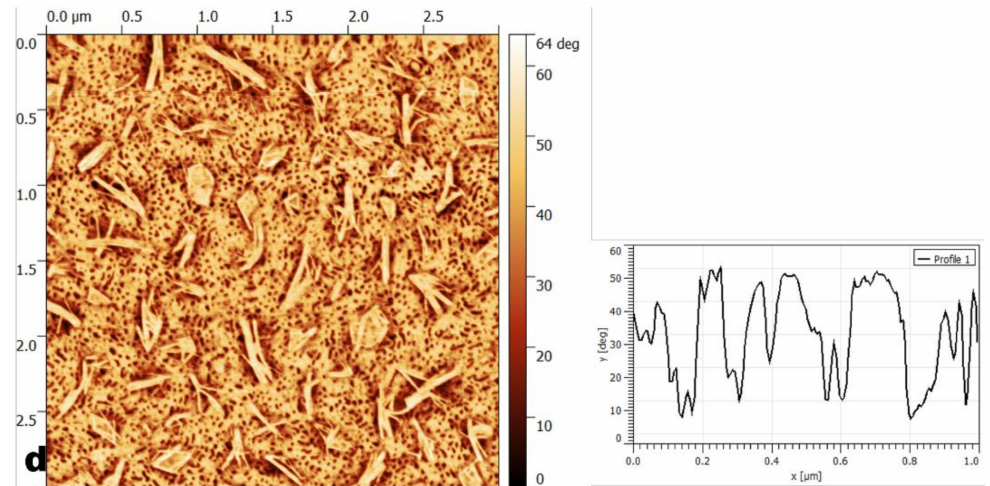
Figure 2. AFM phase images (3 µ m × 3 µ m) and the corresponding cross-sections (1 µ m × 1 µ m) of cylindrical morphologies: ( a ) parallel cylinders (3 wt% poly(styrene-b-isoprene-b-styrene) (SIS) casted from toluene annealed at RT); ( b ) parallel and perpendicular cylinders (3 wt% SIS casted from tetrahydrofuran (THF), annealed at RT); ( c ) perpendicular disordered cylinders (3 wt% poly(styrene-b-butadiene-b-styrene) (SBS) casted from toluene, annealed at RT); ( d ) perpendicular cylinders with large crystal-like